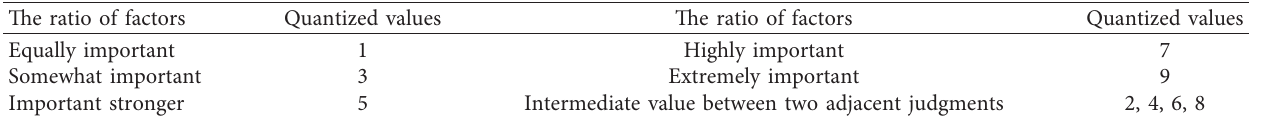
Table 18: 1–9 scaling